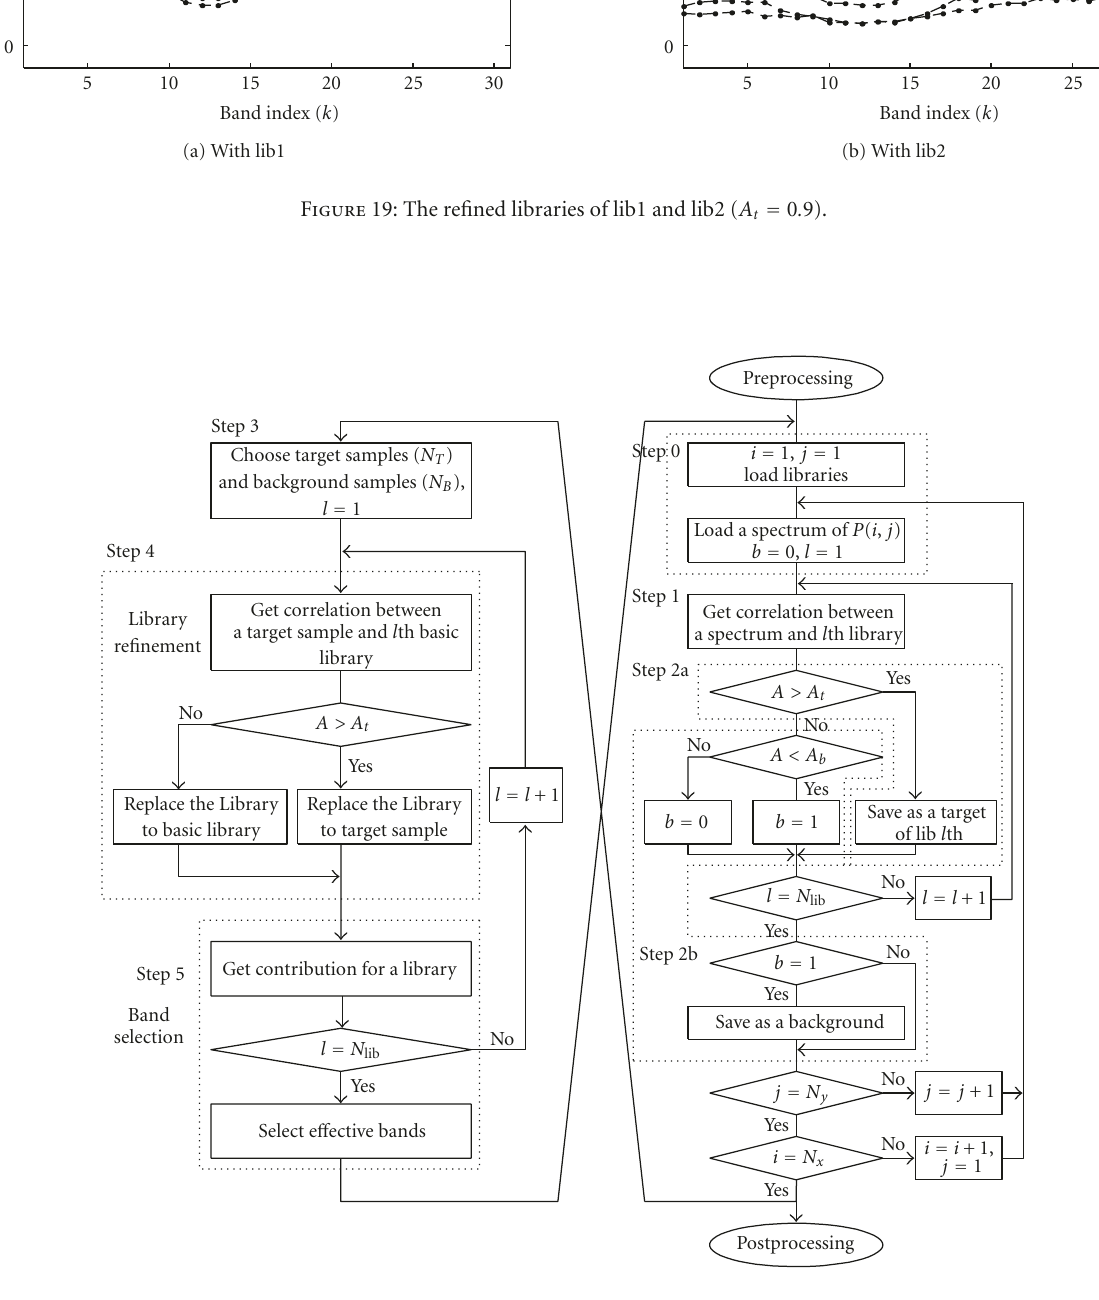
Figure 20: Flowchart of proposed algorithm for the detection